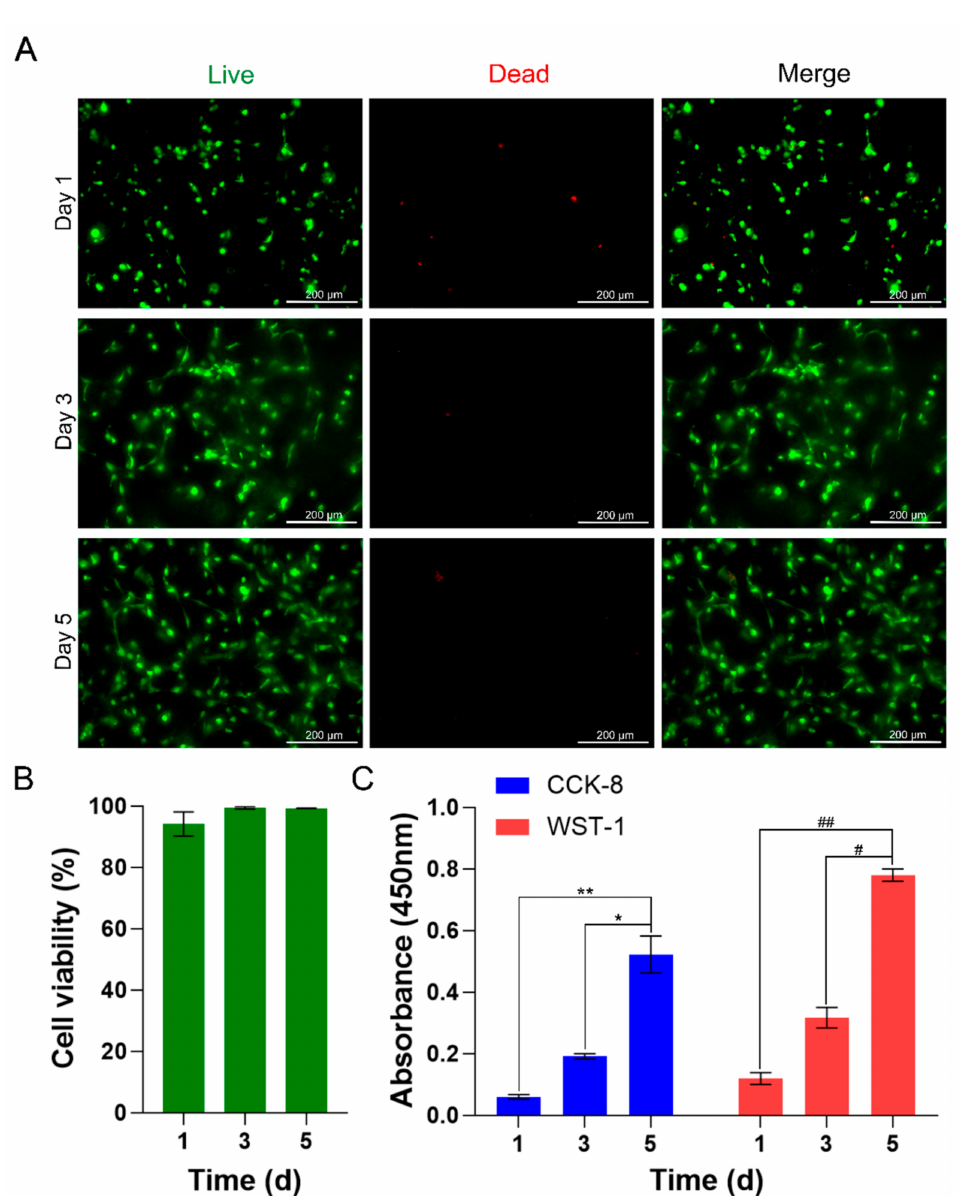
Figure 7. ( A ) Fluorescence microscopy images of Live / Dead assay. BEFCs cultured in Z-stacked sca ff olds after 1, 3, and 5 d. Green indicates live cells and red indicates dead cells. The merged images indicate live and dead cells together. Scale bar = 200 µ m. ( B ) Cell viability obtained from Live / Dead assay of Z-stacked sca ff old at di ff erent time points: 1, 3, and 5 d. There were no statistically significant di ff erences. Data shown are the mean ± SD, n = 4. ( C ) CCK-8 and WST-1 absorbance graph of Z-stacked sca ff old on days 1, 3, and 5. * p < 0.05, ** p < 0.01; # p < 0.05, ## p < 0.01 between the indicated groups. Data shown are the mean ± SD, n =